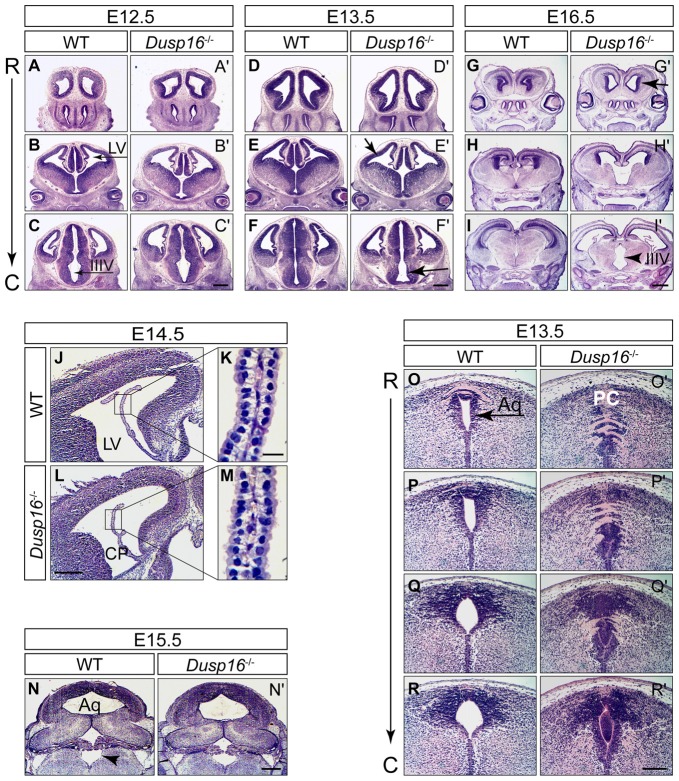
Aqueductal stenosis causes congenital obstructive hydrocephalus in Dusp16−/− mutants. Hematoxylin/Eosin (H&E) serial rostral (R) to caudal (C) coronal sections from E12.5, E13.5 and E16.5 wild types (WTs) and Dusp16−/− mutants are shown with each pair of sections representing approximately the same coronal plane. (A–C′) At E12.5, Dusp16−/− mutants show no changes in the ventricular size. (D–F′) At E13.5 a subtle enlargement of the lateral and third ventricle starts to be visible in Dusp16−/− mutants. (G–I′) At E16.5 enlargement of the ventricles are clearly visible (arrows). Scale bars: (C′,F′) 500 μm; (I′) 200 μm. (J–M) H&E staining of coronal hemisections through LV of WT and Dusp16−/− brains at E14.5. The overall morphology of CP appears normal in Dusp16−/− mutants (L,M) compared with control littermates (J,K). Higher magnification of the areas marked by boxes shows that cytoplasmic volume of the CP epithelial cells in Dusp16−/− mutants (M) is unperturbed compared with WT (K). (N,N′) H&E staining of coronal sections through the fourth ventricle of WT and Dusp16−/− heads at E15.5 demonstrating the same size of the fourth ventricle in Dusp16−/− compared with WT (arrowhead). (O–R′) H&E staining of coronal sections through the Aq of WT and Dusp16−/− heads at E13.5 revealed a near complete obstruction in Dusp16−/− mutants. Scale bars: (L) 500 μm; (K) 20 μm; (N′) 500 μm; (R′) 200 μm. Aq, Aqueduct of Sylvius; C, caudal; LV, lateral ventricle; IIIV, third ventricle; PC, posterior commissure; R, rostral; CP, choroid plexus.